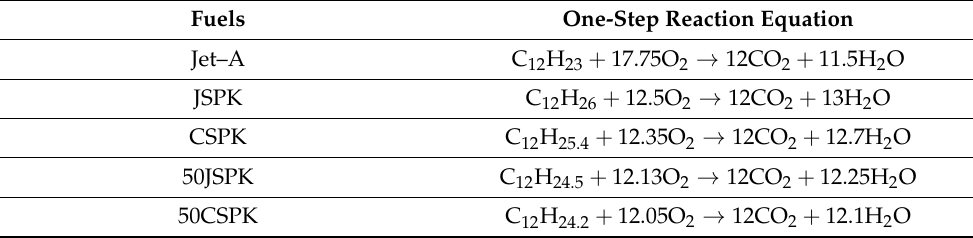
Table 5. One step global chemical reaction for each tested fuel.